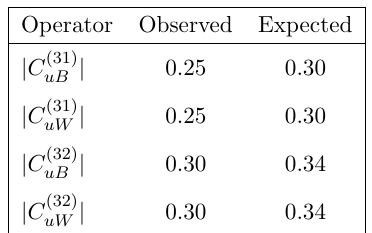
Table 11 . Observed and expected 95% CL upper limits on the moduli of the operators contributing to the FCNC decays t ! uZ and t ! cZ within the TopFCNC model for a new-physics energy scale (cid:3) = 1 TeV.